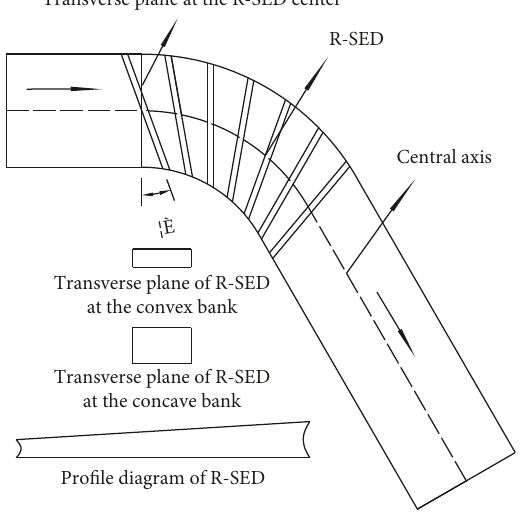
Figure 4: R-SED layout and section